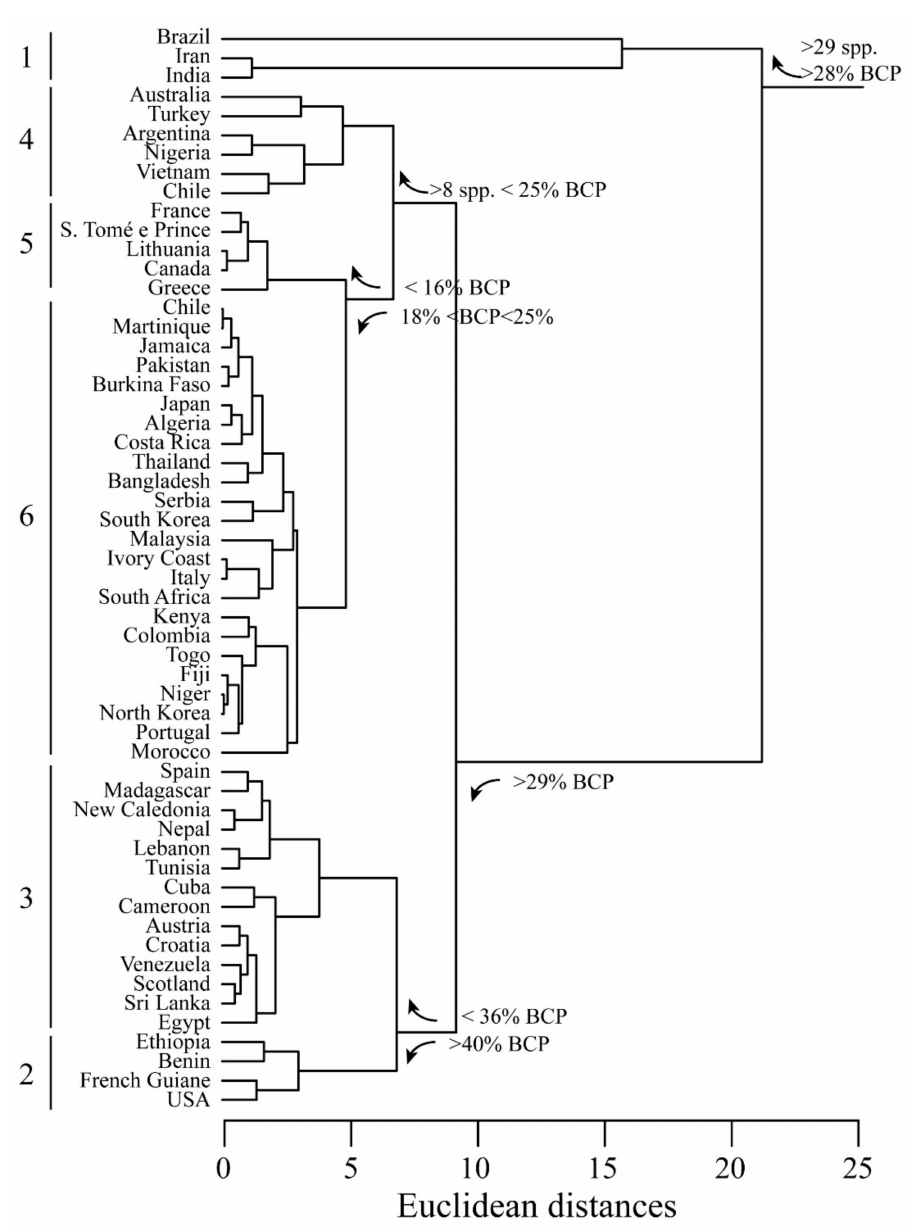
Figure 4. Cluster analysis of BCP and yield percentages according to the country of origin of extracts. Euclidean distances are calculated with average linkage method. Six clusters are evident (see text for